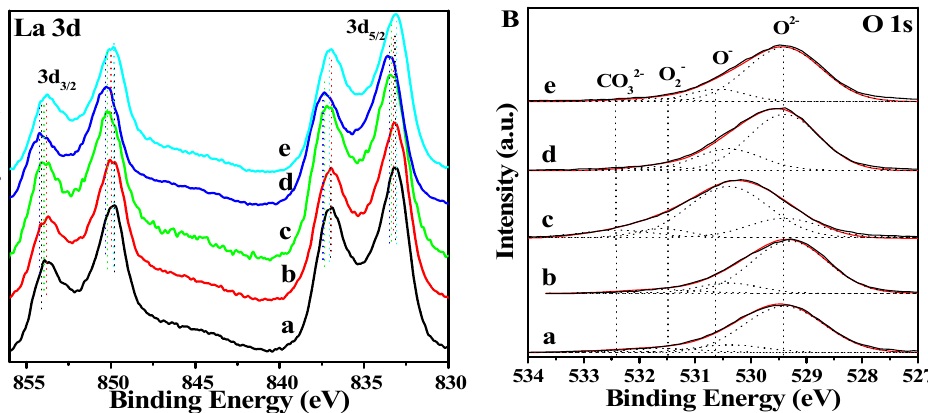
Figure 7. XPS spectra of La3d ( A ) and O1s ( B ) over the La 2 O 3 and X-La 2 O 3 catalysts. ( a ) La 2 O 3 ; ( b ) Li-La 2 O 3 ; ( c ) Mg-La 2 O 3 ; ( d ) Zn-La 2 O 3 ; ( e ) Ce-La 2 O 3.